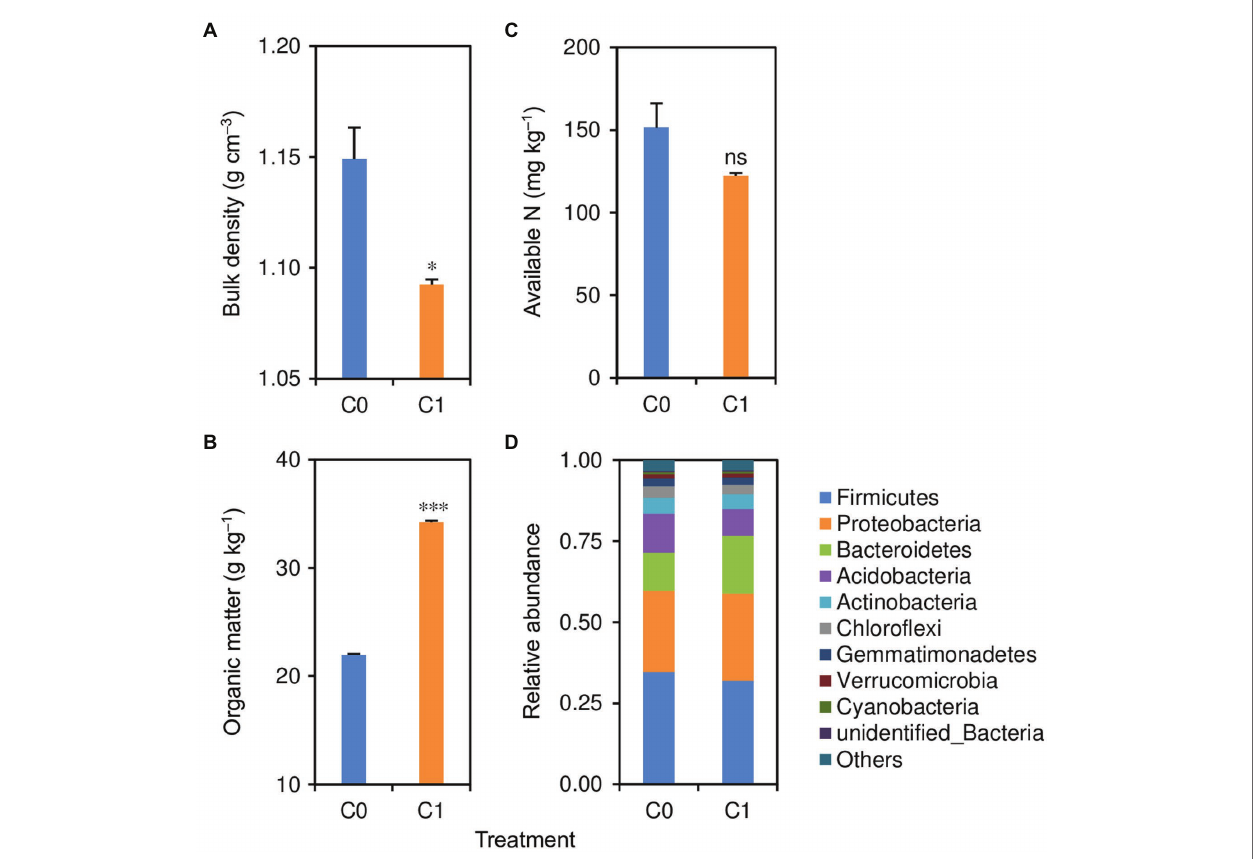
FIGURE 2 | (A) Soil bulk density, (B) organic matter content, (C) available N content, and (D) relative abundance of bacterial phyla in treatments with (C1) and without (C0) biochar application. * and *** indicate that the means of the rice plants in C1 treatment are significantly different from those in the C0 treatment at the 0.05 and 0.001 levels, respectively. “ns” indicates that the mean of the rice plants in C1 treatment is not significantly different from that in the C0 treatment at the 0.05 level.